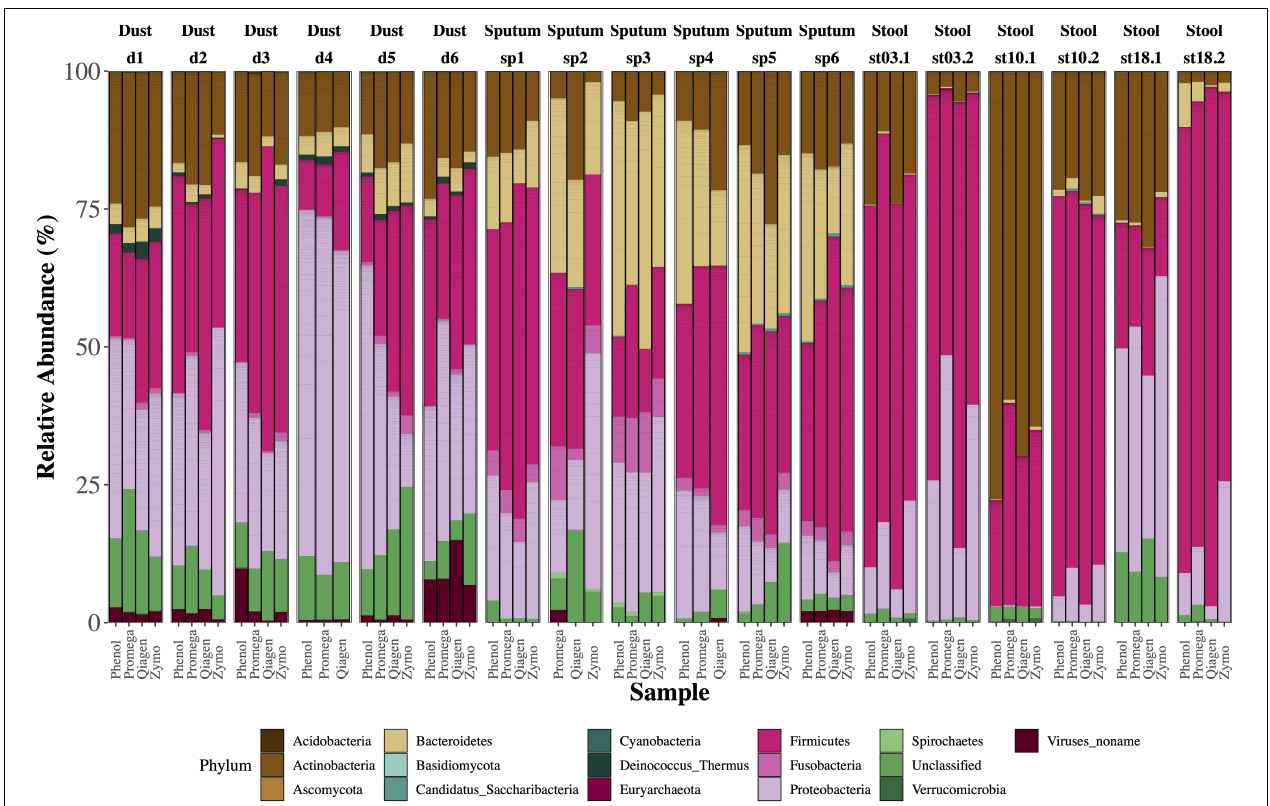
FIGURE 3 | Relative abundance of microbes by sample type. Single bars represent one sample and each color shown represents one phylum. For each sample type (dust, sputum, stool), there were six biological replicates with four aliquots each which underwent a different extraction method. Several samples failed library prep including one dust sample (extracted by Zymo) and two sputum samples (one which underwent extraction by phenol:chloroform, the other by Zymo). For stool samples, the age of the sample is depicted with “stXX.” For example, “st03.2” refers to a stool sample stored for 3.2 years, “st10” refers to a stool sample stored for 10 years, and “st18” refers to a stool sample stored for 18